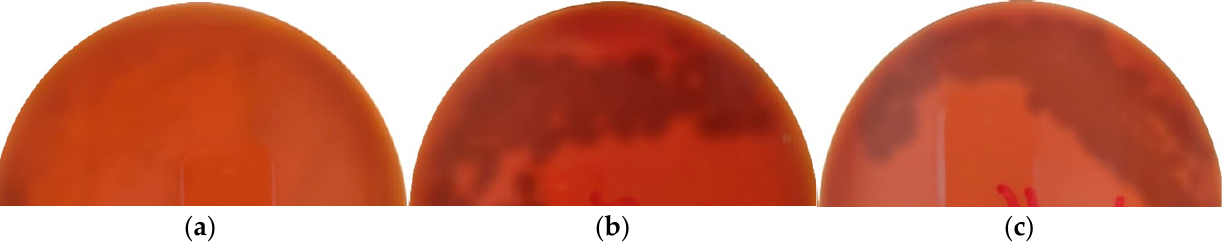
Figure 4. Hemolysis analysis picture results for ( a ) L. lactis A12, ( b ) P. megaterium M4, ( c ) Priestia sp.